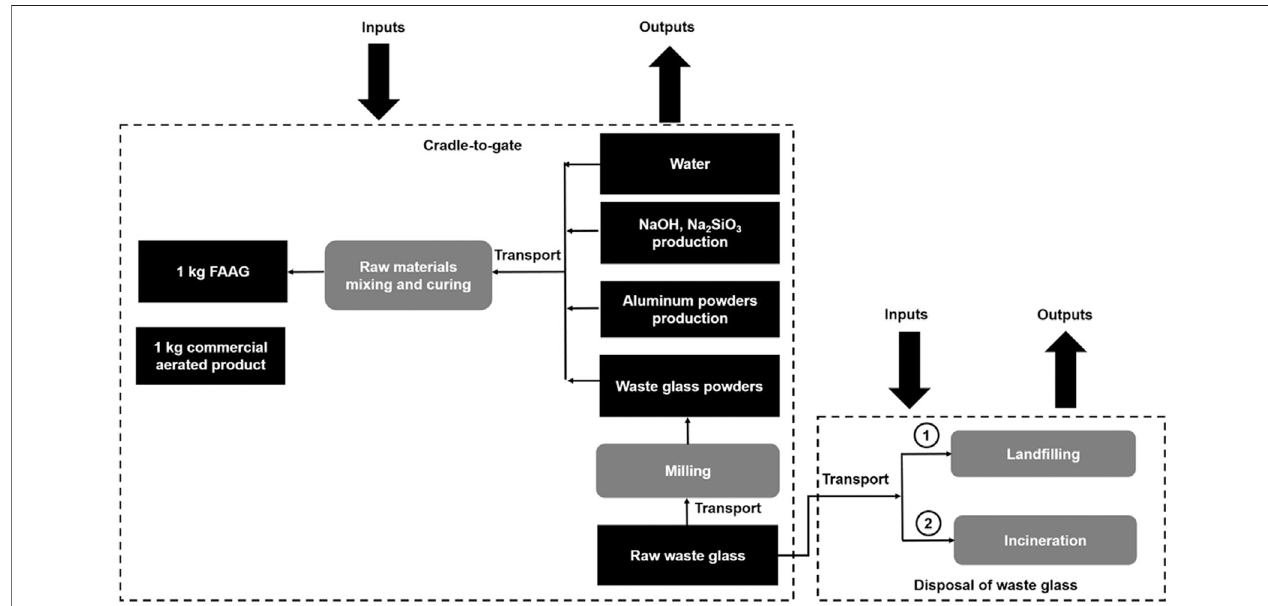
FIGURE 4 | System boundary of environmental assessment in view of preparation of 1 kg foamed alkali-activated glass considering impacts of waste glass disposal as well as 1 kg commercial aerated products.